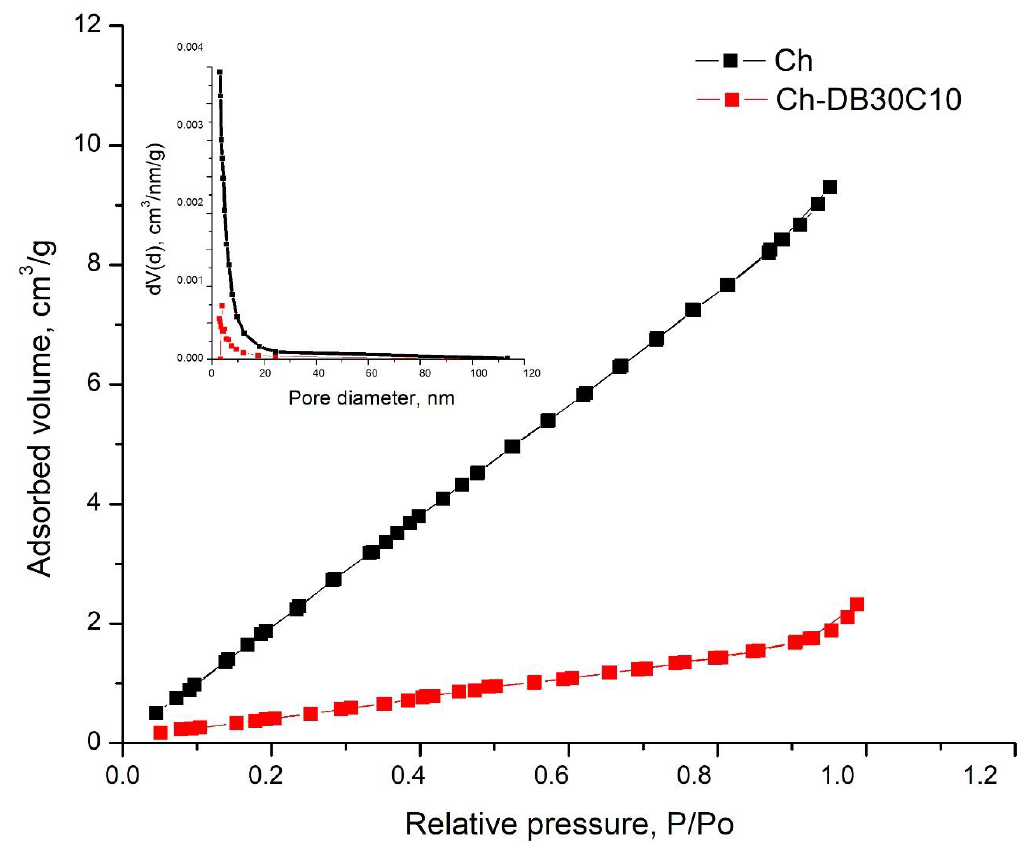
Figure 3. Determination of the specific surface using the BET method.